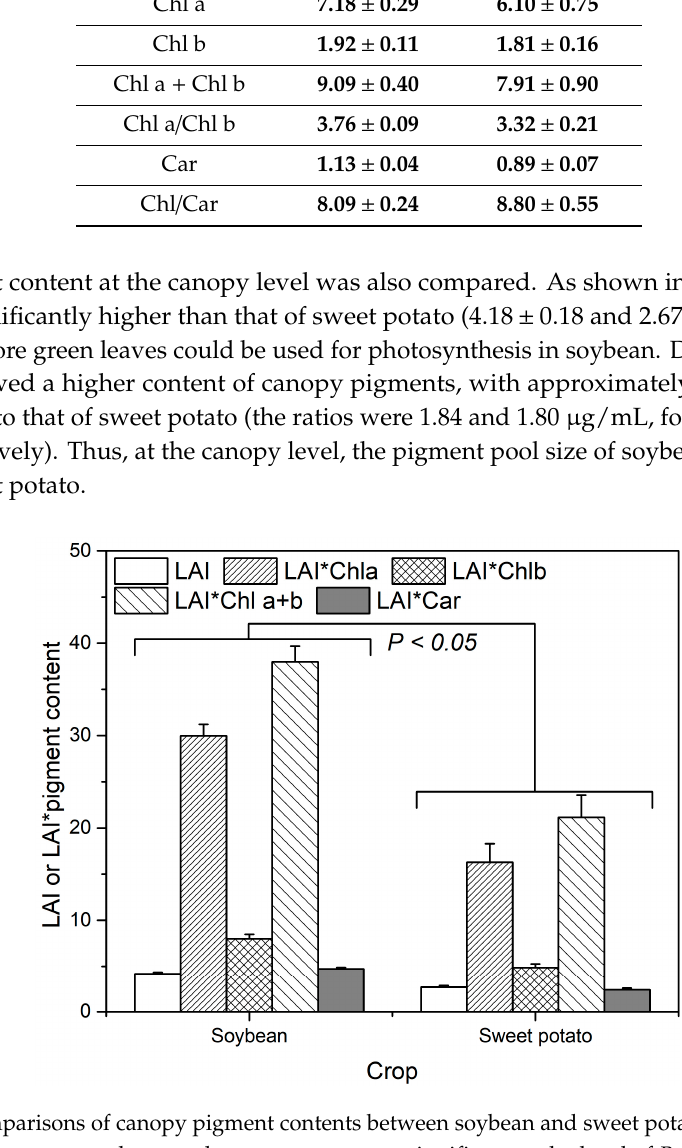
Table 2. Pigment concentrations ( µ g/mL of plant extract) with values of mean ± stand error of mean. Pigments Table 2 . Pigment concentrations ( μg ml⁄ of plant extract ) with values of mean ± stand error of mean